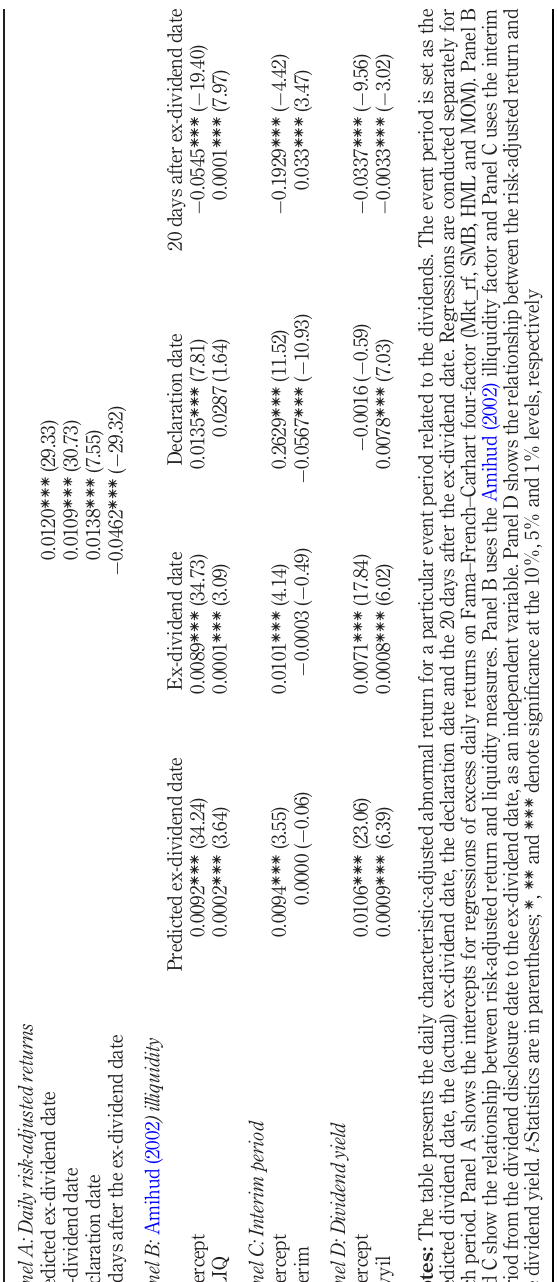
Table 7. Daily characteristic- adjusted